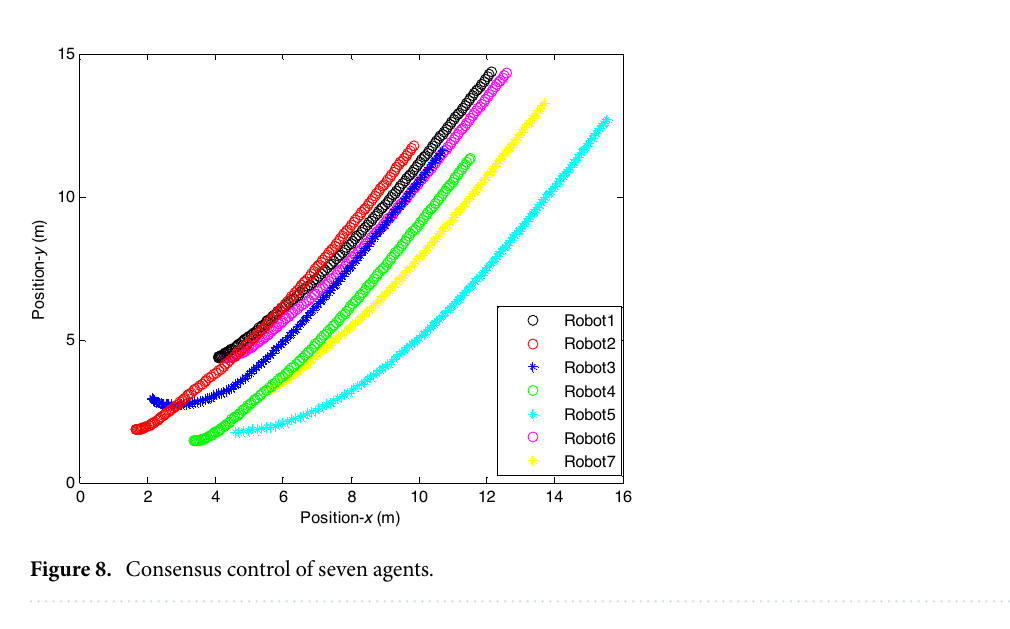
Figure 7. Consensus control on heading angle of seven agents with attacks at initial time.